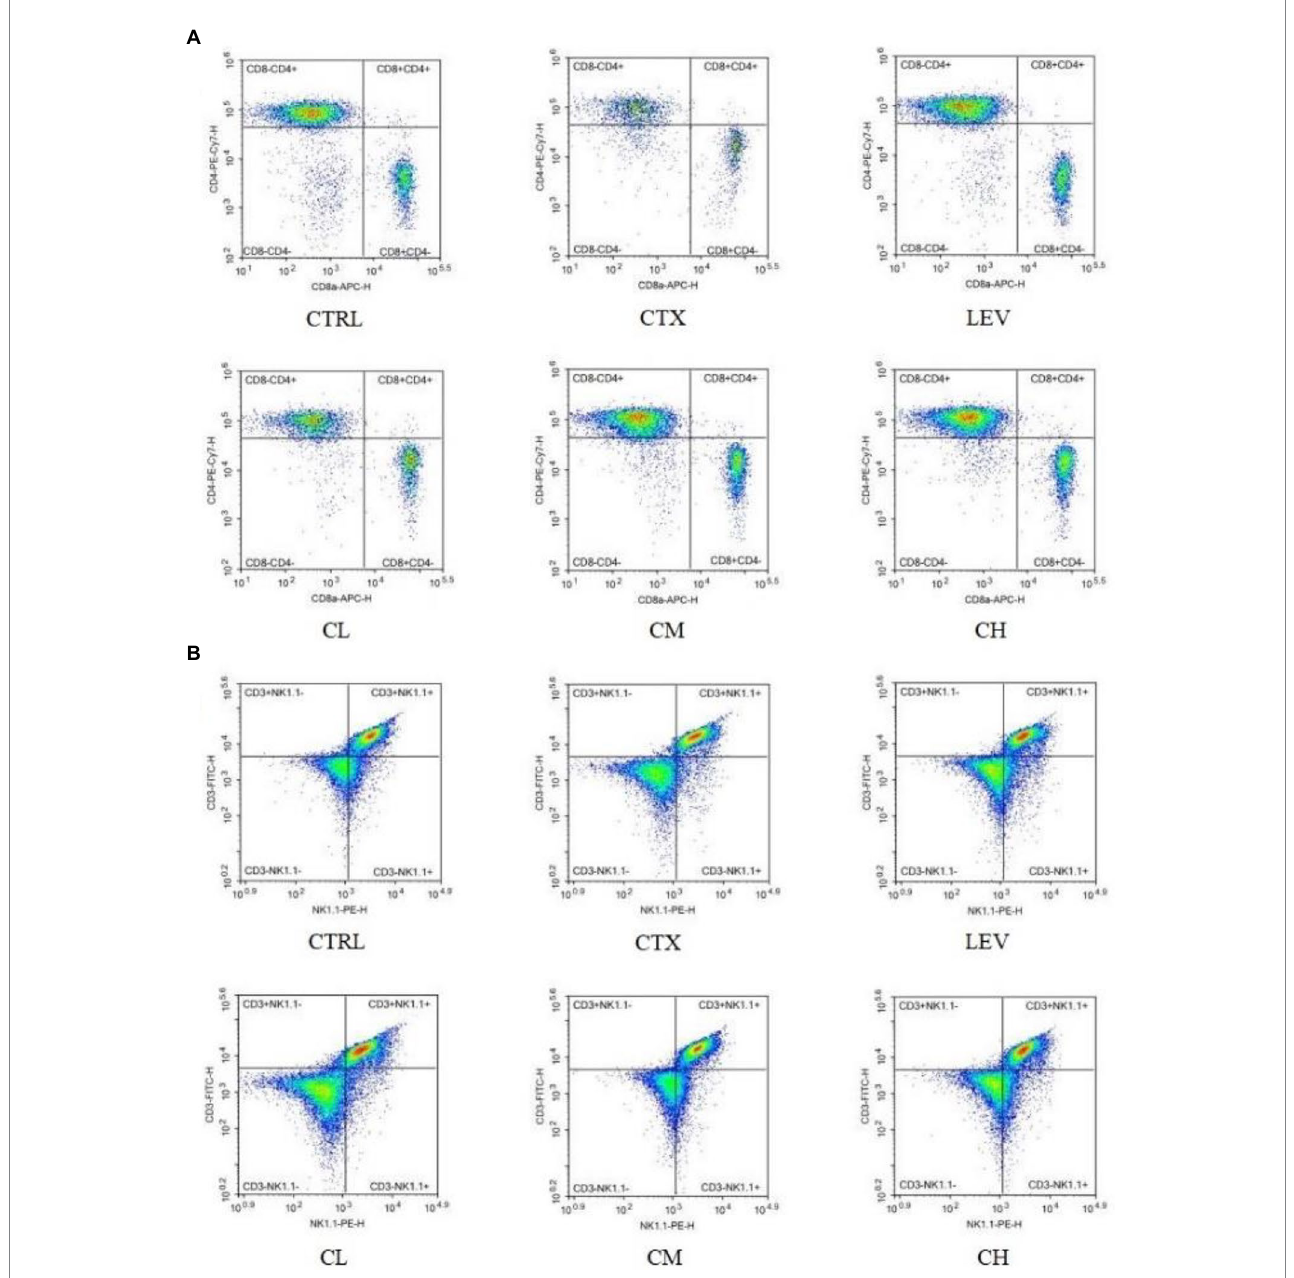
FIGURE 4 Percentage of splenic lymphocyte subsets of mice in various groups detected by flow cytometry. (A) CD4 + CD8 − and CD4 − CD8 + T lymphocytes, (B) CD3 + and NK